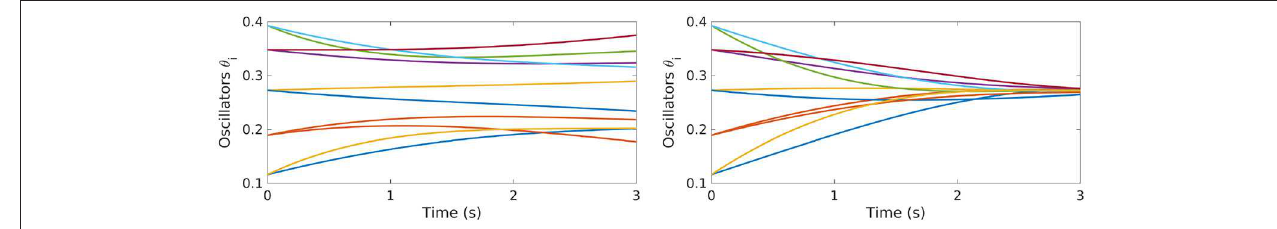
10 oscillators, K > K * and =